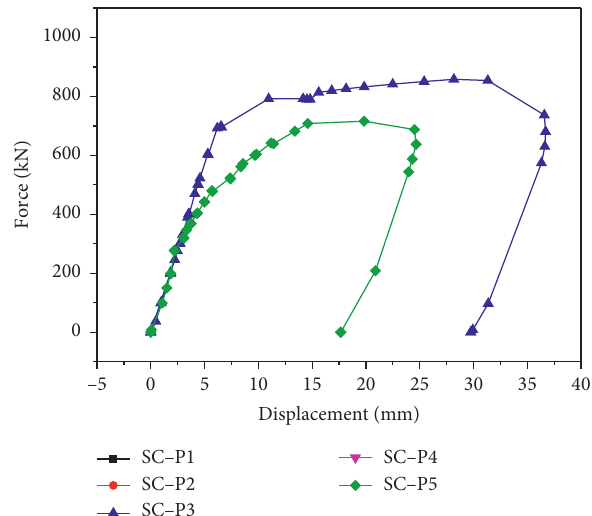
Figure 24: Load-midspan deflection curves of SC-P3 and